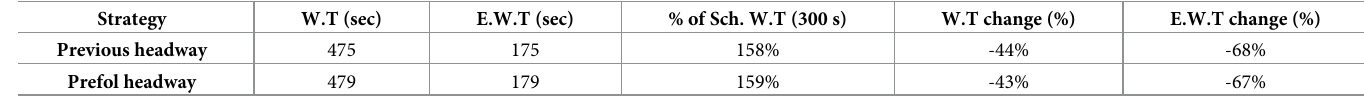
Table 13. Effect of holding strategies on waiting time.